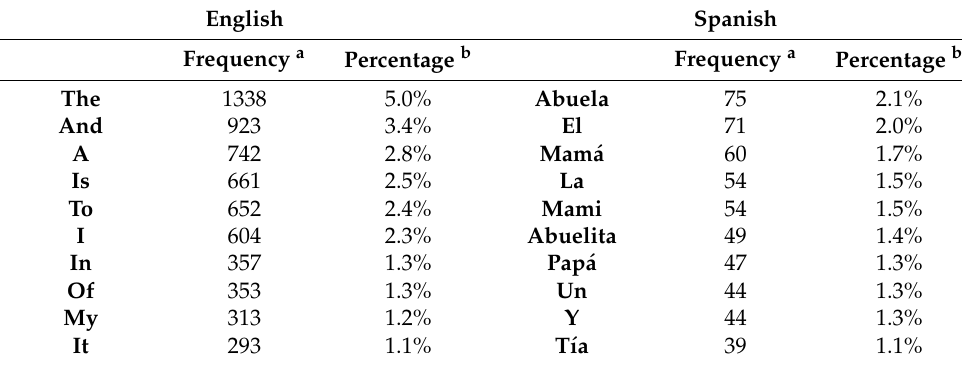
Table 2. Raw counts of 10 most frequent words per